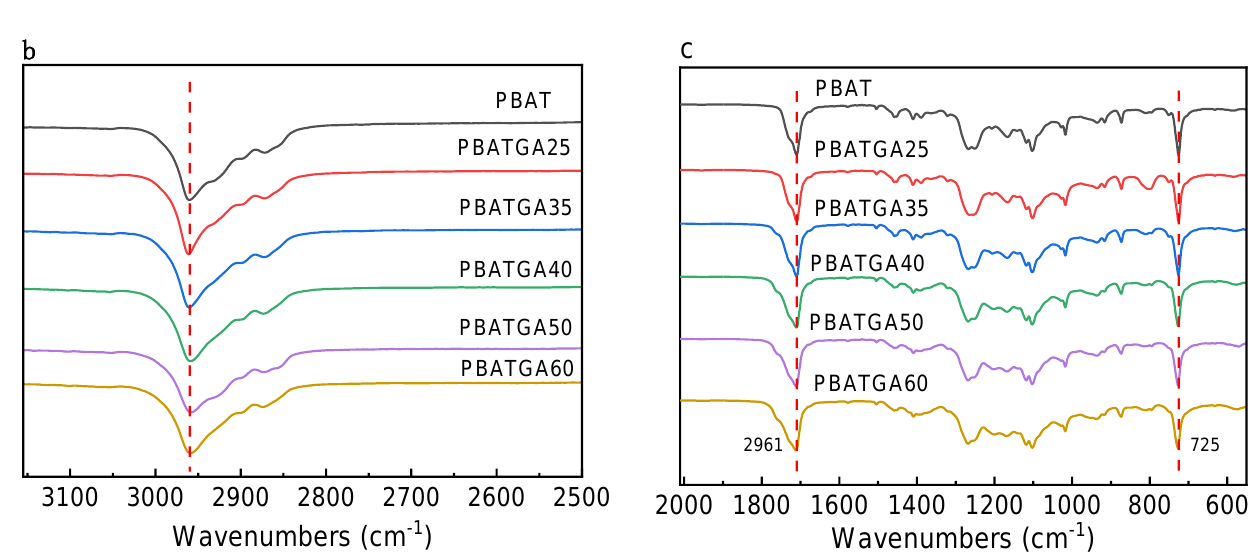
Figure 1. ( a ) ATR-FTIR spectra of PBATGAs; ( b ) enlargement of 2500–3100 cm − 1 ; ( c ) enlargement of 600–2500 cm − 1 .